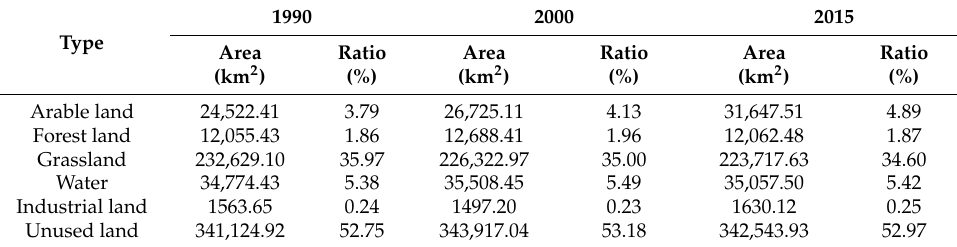
Table 1. Areas and proportions of land-use types in the study area in 1990, 2000, and